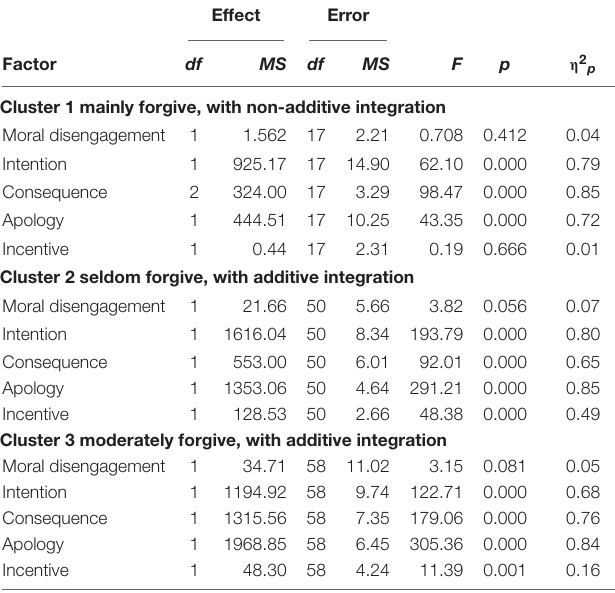
TABLE 1 | Main results of the ANOVAs performed on cluster 1, cluster 2 and cluster 3. Effect